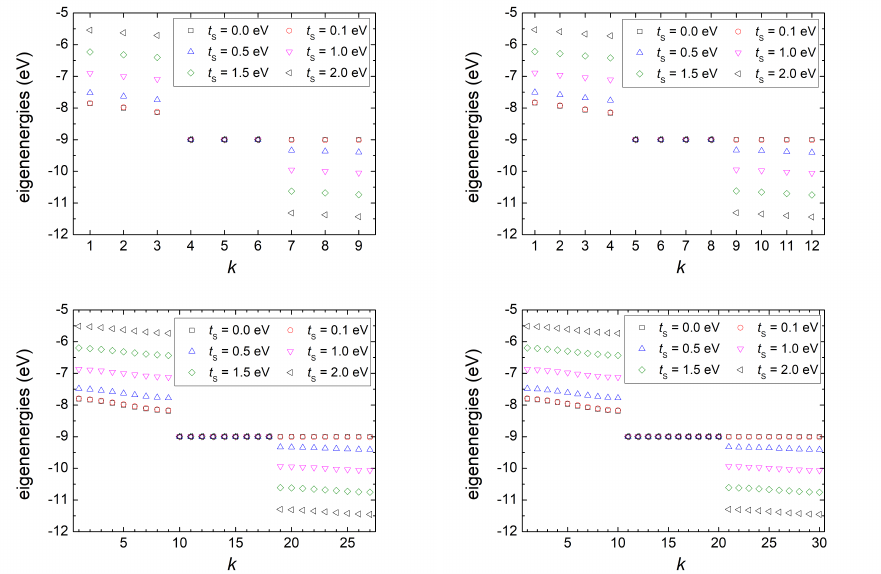
Figure 2. The eigenenergies, indexed in descending order by k for different values of the interaction parameter between base pairs and deoxyriboses, t S for a G... homopolymer made of N = 3, 4, 9, and 10 monomers (from top left to bottom